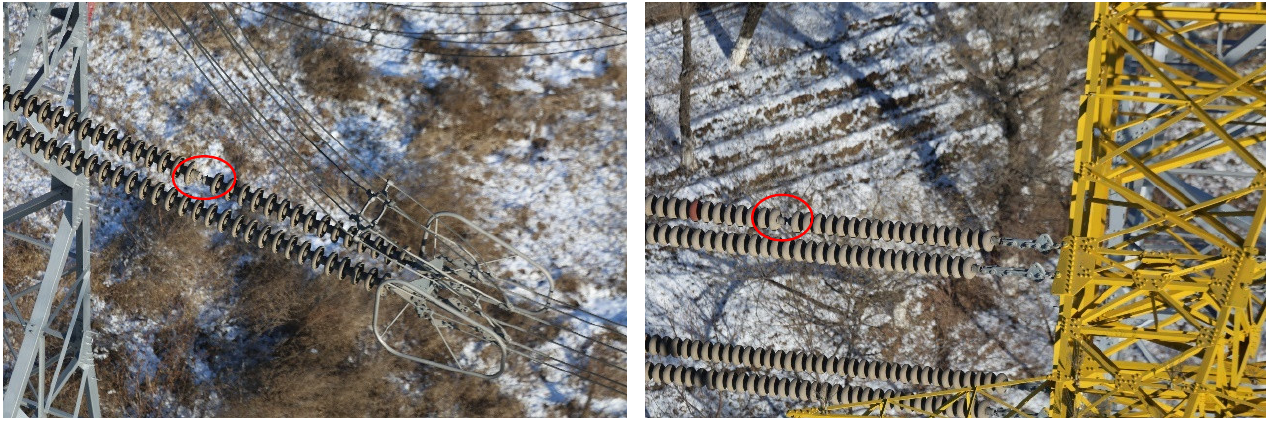
Figure 13. The flight trajectories of yaw gimbal in inspection test.